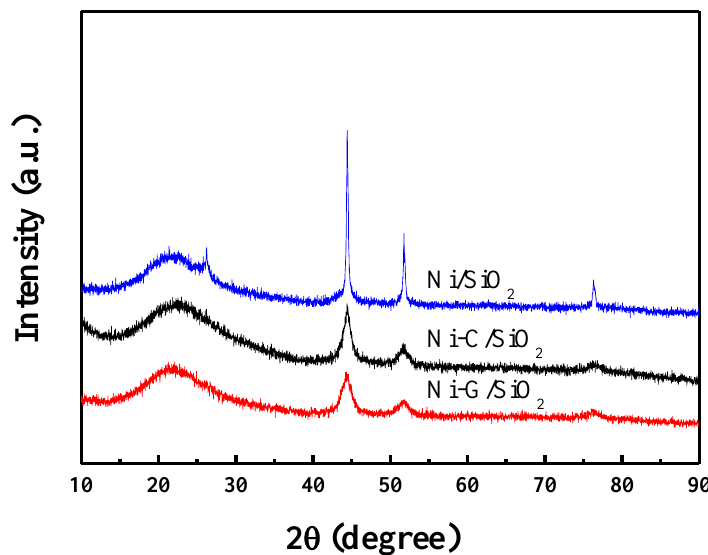
Figure 5. XRD pattern for the used catalysts after CDR under the conditions of P = 1.0 atm, T = 750 °C, CH 4 /CO 2 = 1.0, GHSV = 60,000 mL·g −1 ·h −1 , and TOS = 20 h.